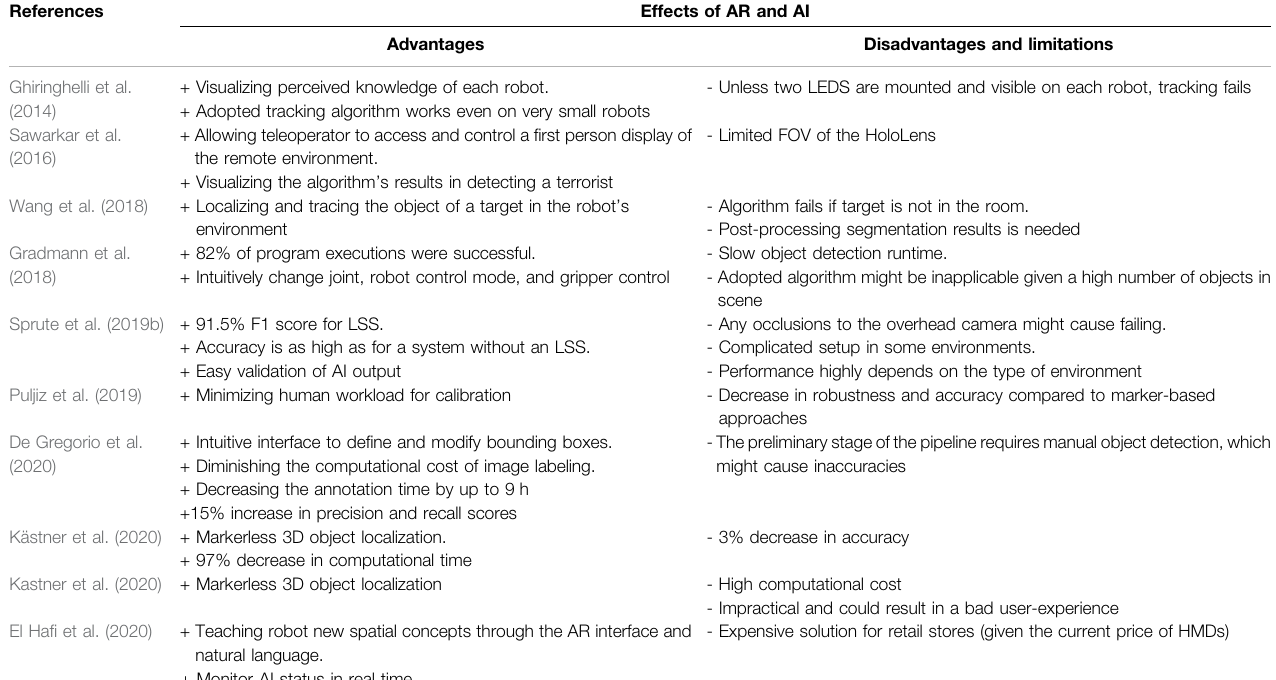
TABLE 5 | The advantages as well as the disadvantages and limitations of each method in the Perception